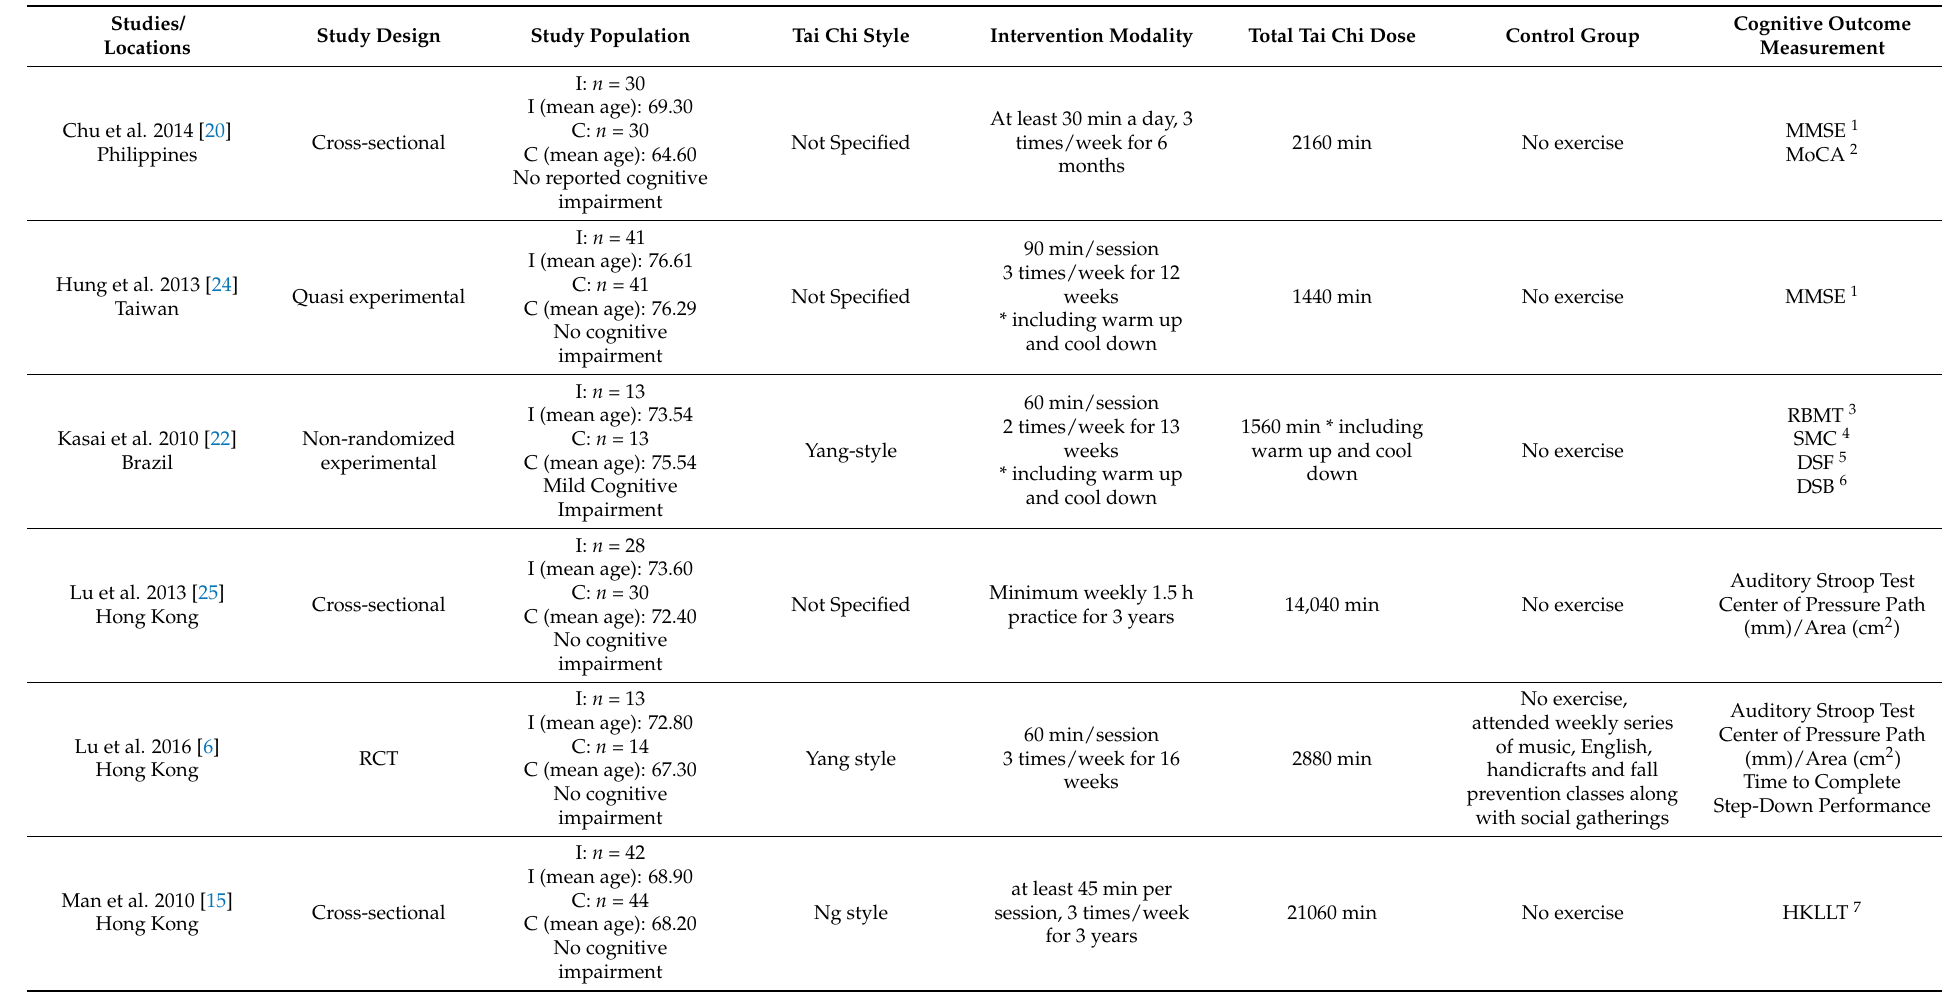
Table 1. Characteristics of the included Tai Chi studies on the cognitive function in community-dwelling older